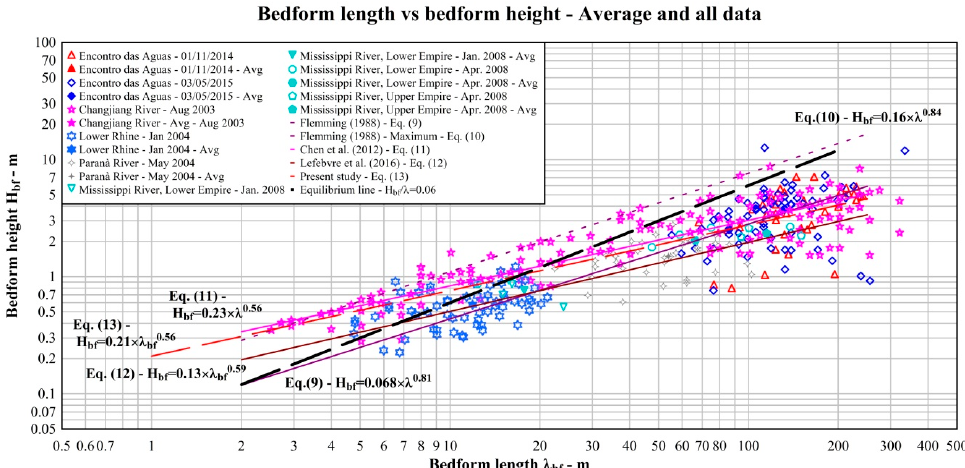
Figure 18. Bedform wavelength vs. bedform wave height, comparison with literature data from large rivers.